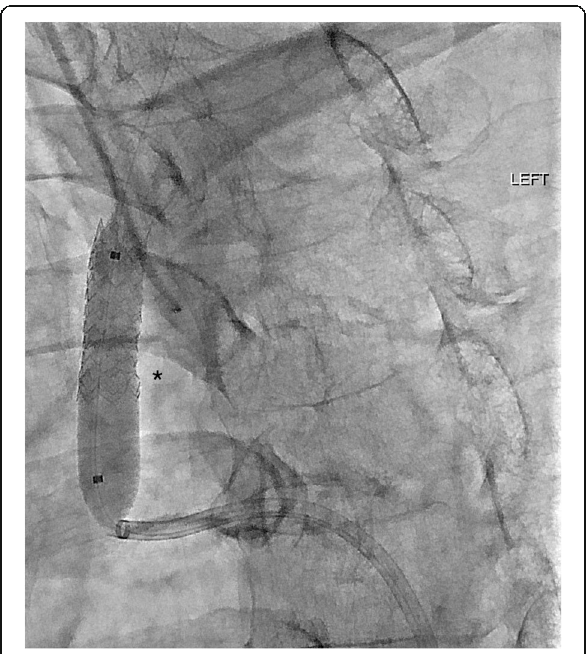
Fig. 4 Balloon remodelling of the CCA stent (*). The proximal aspect of the stent is slightly flared at the CCA